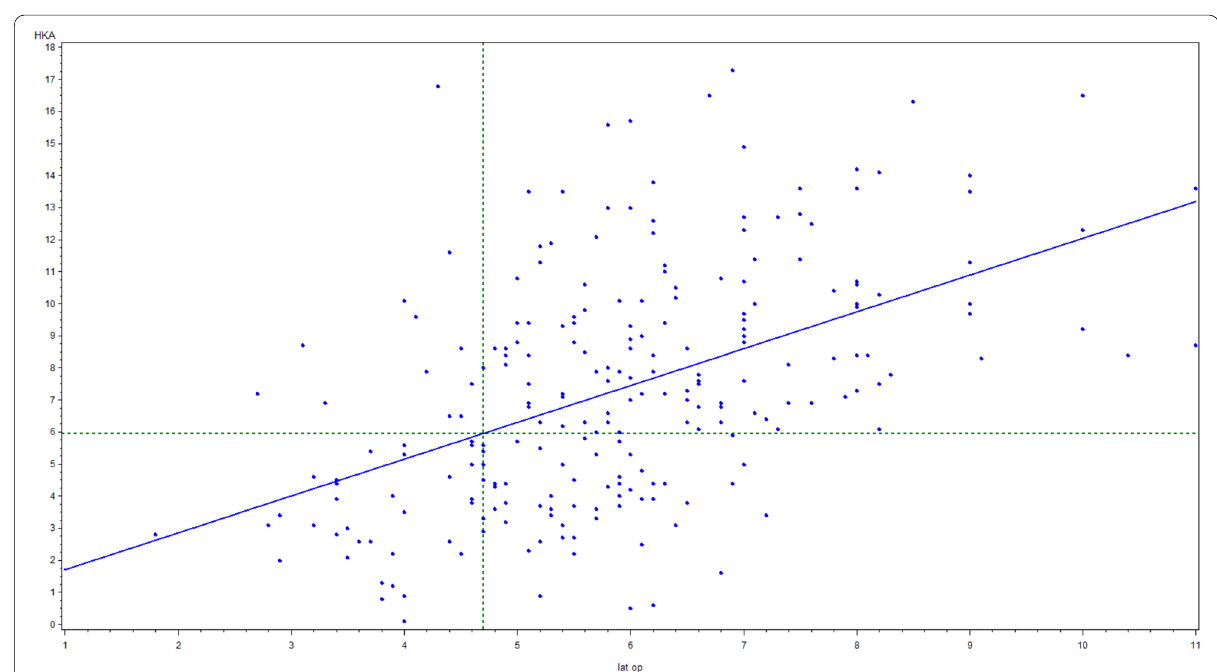
Fig. 3 In this graph, the lateral opening (measured in mm) is plotted on the X-axis and the HKA (measured in degrees) on the Y-axis. The corresponding mean HKA for a lateral opening of 4.7 mm is 5.95 with a 95% CI [5.45; 6.45]